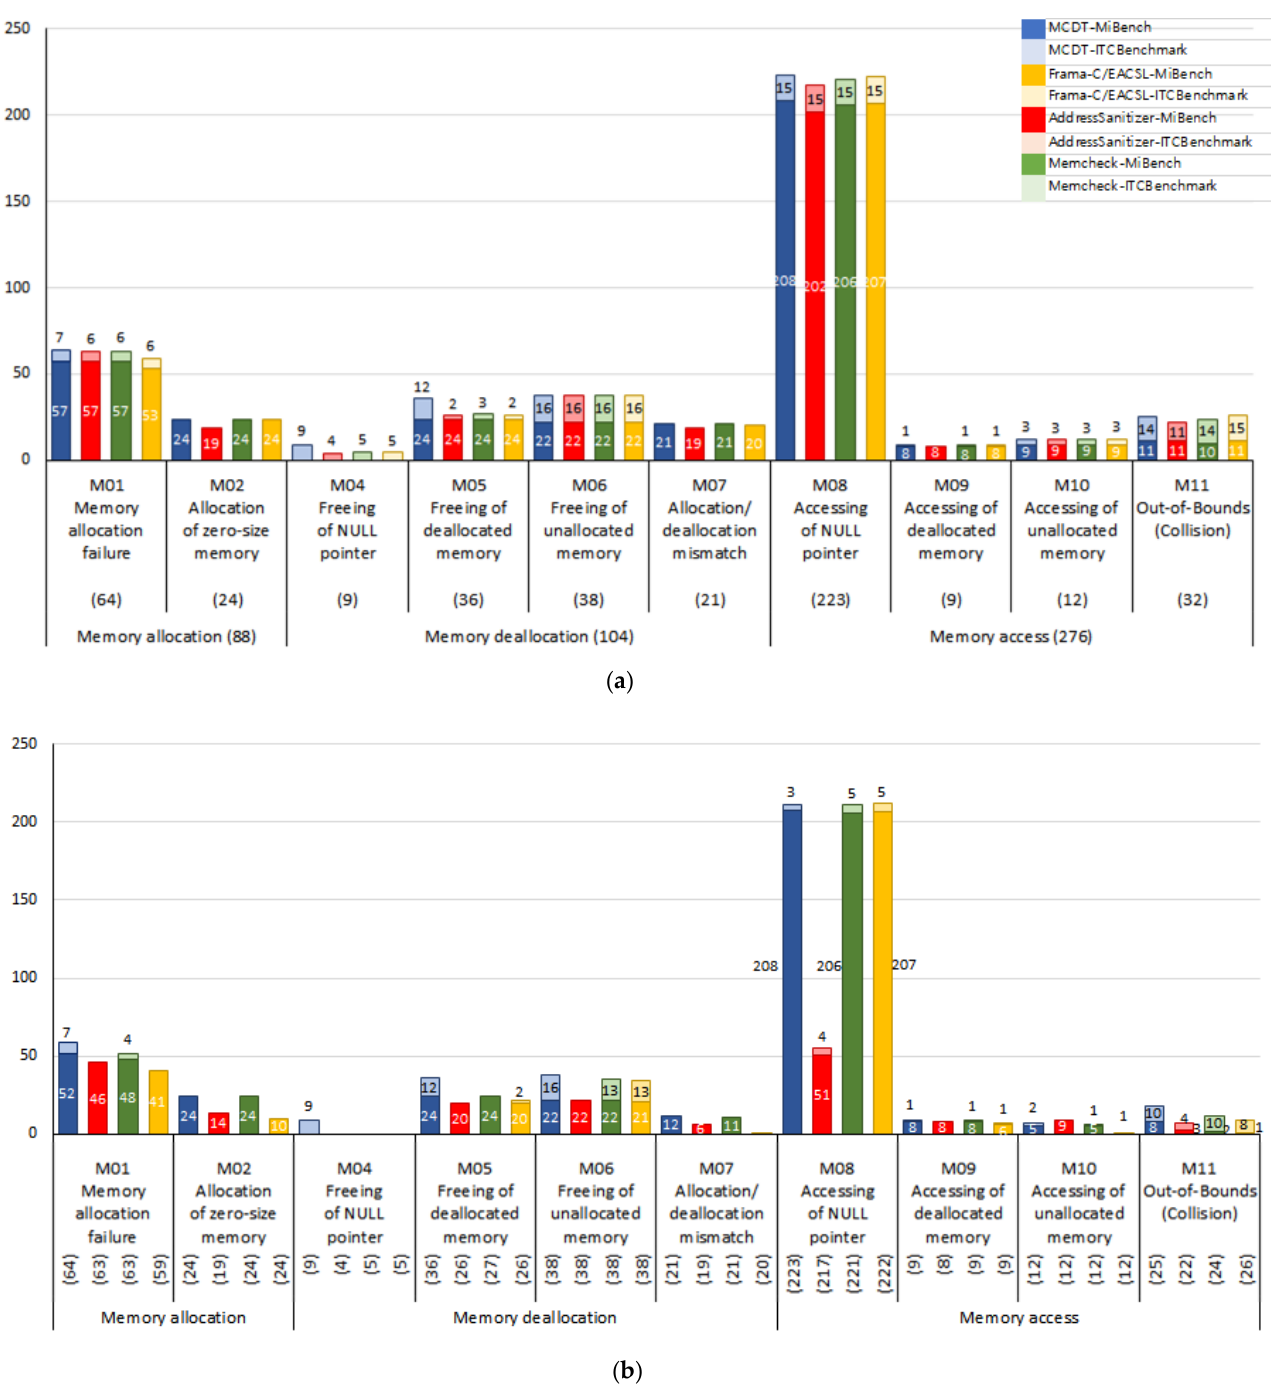
Figure 15. ( a ) Number of defects detected; ( b ) number of defects for which the cause was accurately analyzed.